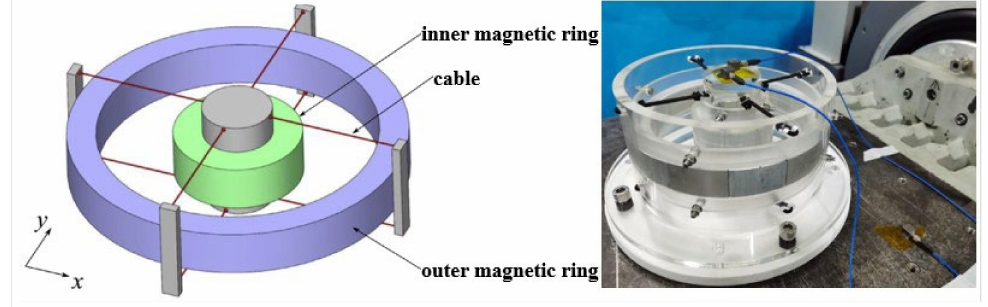
Figure 10. Schematic diagram of multi-direction QZS vibration isolation structure. Reprinted/ adapted with permission from Ref. [80]. Copyright 2021 Elsevier Inc., Chaoran Liu and Rui